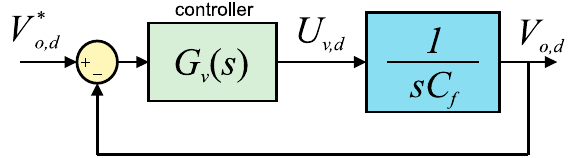
Figure 3. The voltage control loop.